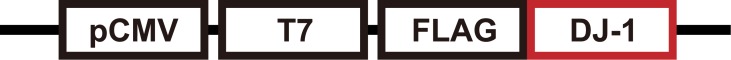
The plasmid pcDNA3-Flag-DJ-1 simplified structure.